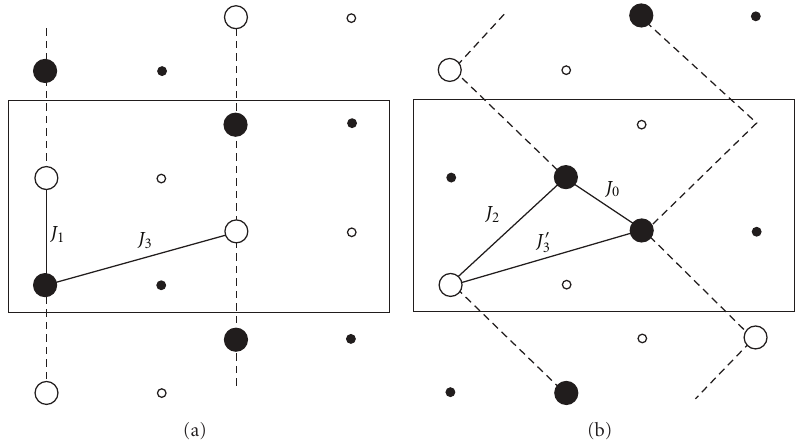
Figure 30: (a) In-line charge ordering of V 4+ ions. (b) Zig-zag charge ordering of V 4+ ions [245]. Big balls: V 4+ spinup, big circles: V 4+ spindown, and small balls and circles: V 5+ . The nominally V 5+ ions inherit a small spin moment from their V 4+ partners in the same rung; see